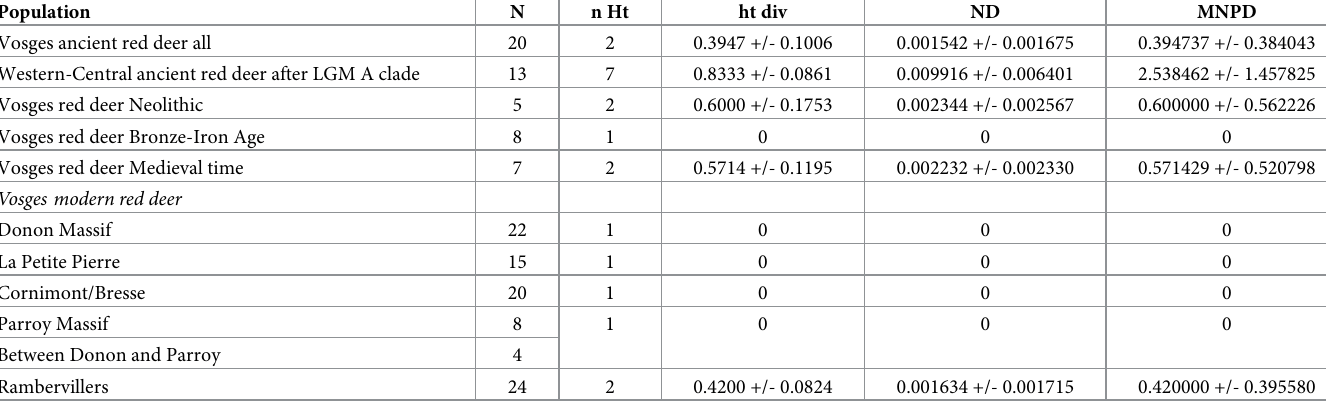
Table 1. Diversity measures (haplotype diversity = htdiv; nucleotide diversity = ND, mean number of pairwise distances = MNPD) within the concatenated 256 bp fragment of cyt b and d-loop in ancient and modern red deer from the Vosges in comparison with published ancient western-central European red deer